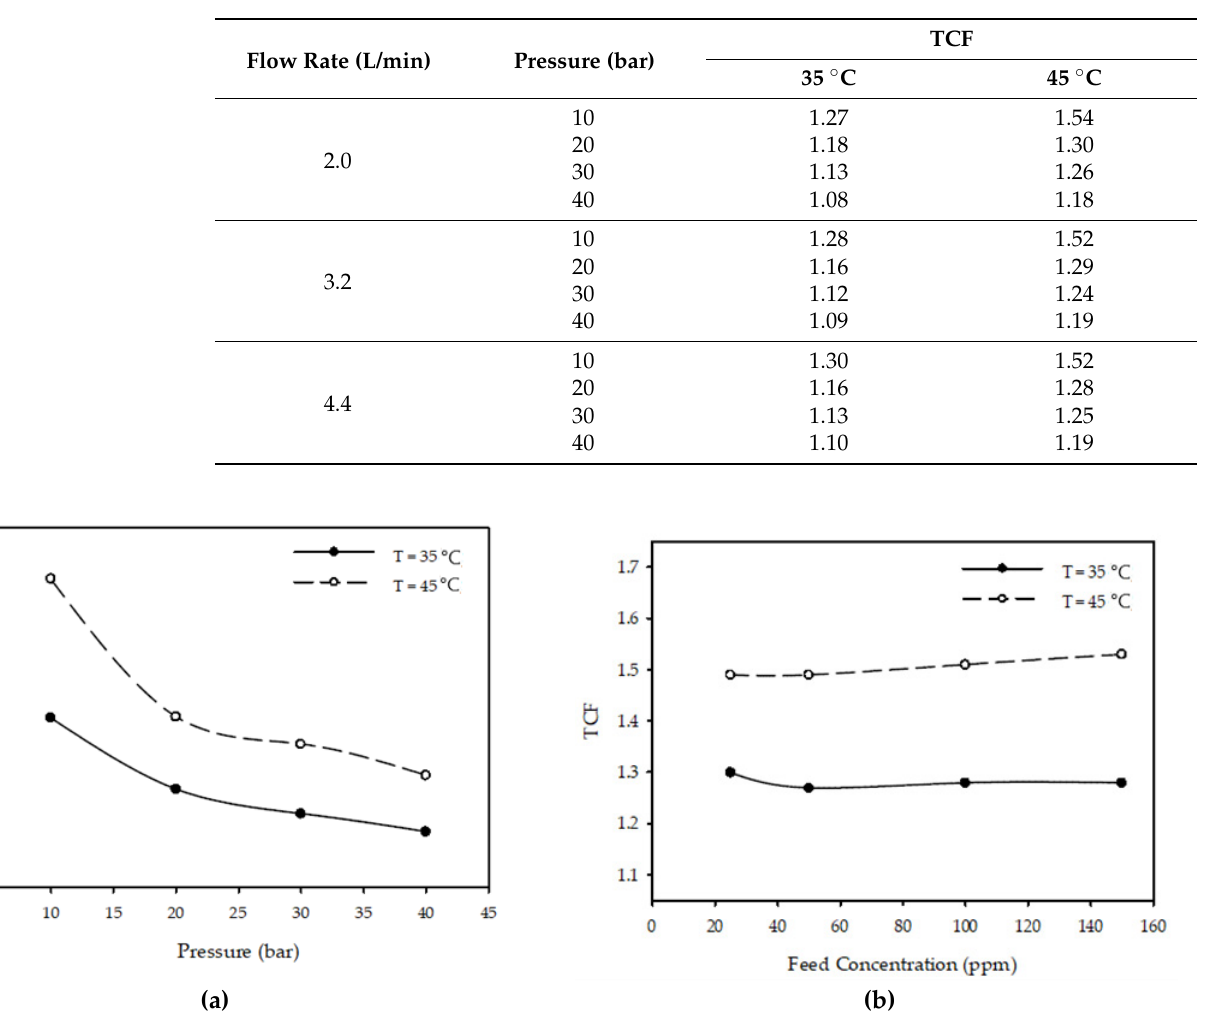
Table 2. Temperature correction factor values with different operating pressures and flow rates, and a feed concentration of 100 ppm.